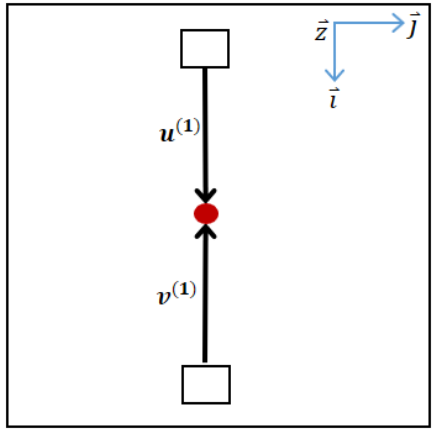
Figure 2. Diagram of the guided wave mixing concept on a plate. Equation (11) can be derived by substituting two primary waves based on Equations (9) and (10) in Equation (7). After a few rearrangement steps, Equation (12) is obtained. Here, there are two out-of-plane dominant mixing waves. The frequency of the first one is the difference of the two primary wave frequencies ( ω 1 − ω 2 ) , while that of the second one is the sum ( ω 1 + ω 2 ) . The point of interest is the difference-frequency mixing signal for dominant out-of-plane displacement, so the sum-frequency component is ignored.